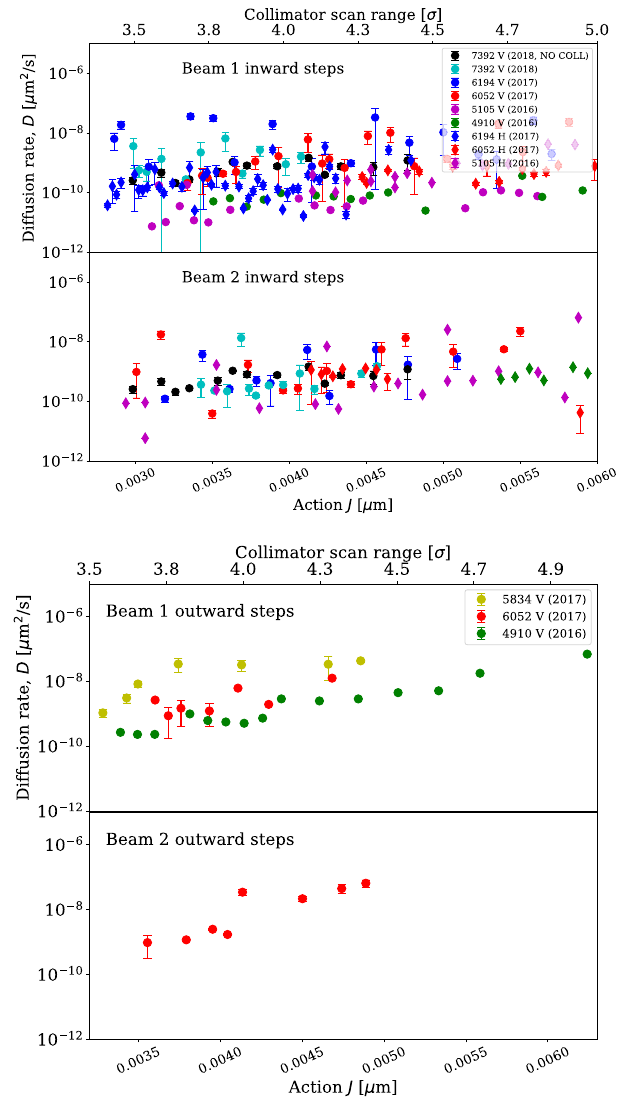
FIG. 11. Estimated diffusion coefficients for two beams for the inward (top) and the outward (bottom) steps. Different colors represent different fills from the summary in Table III. Each data point is an average of all bunch measurements from acquisitions at 100